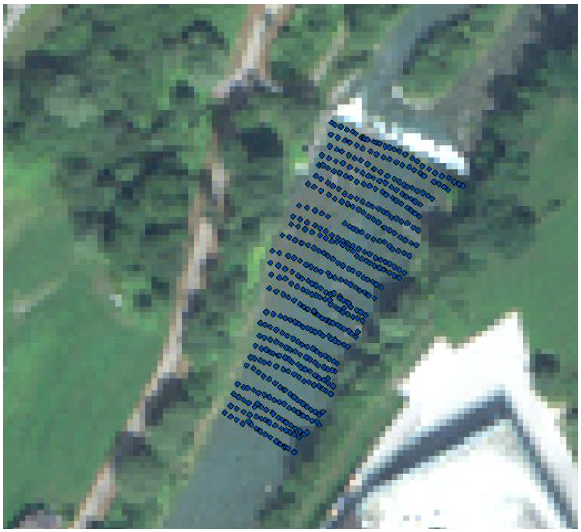
Figure 2. In-situ measurements of water depths in a reach of Sarca river superimposed on true colour composition of the WV-3 image